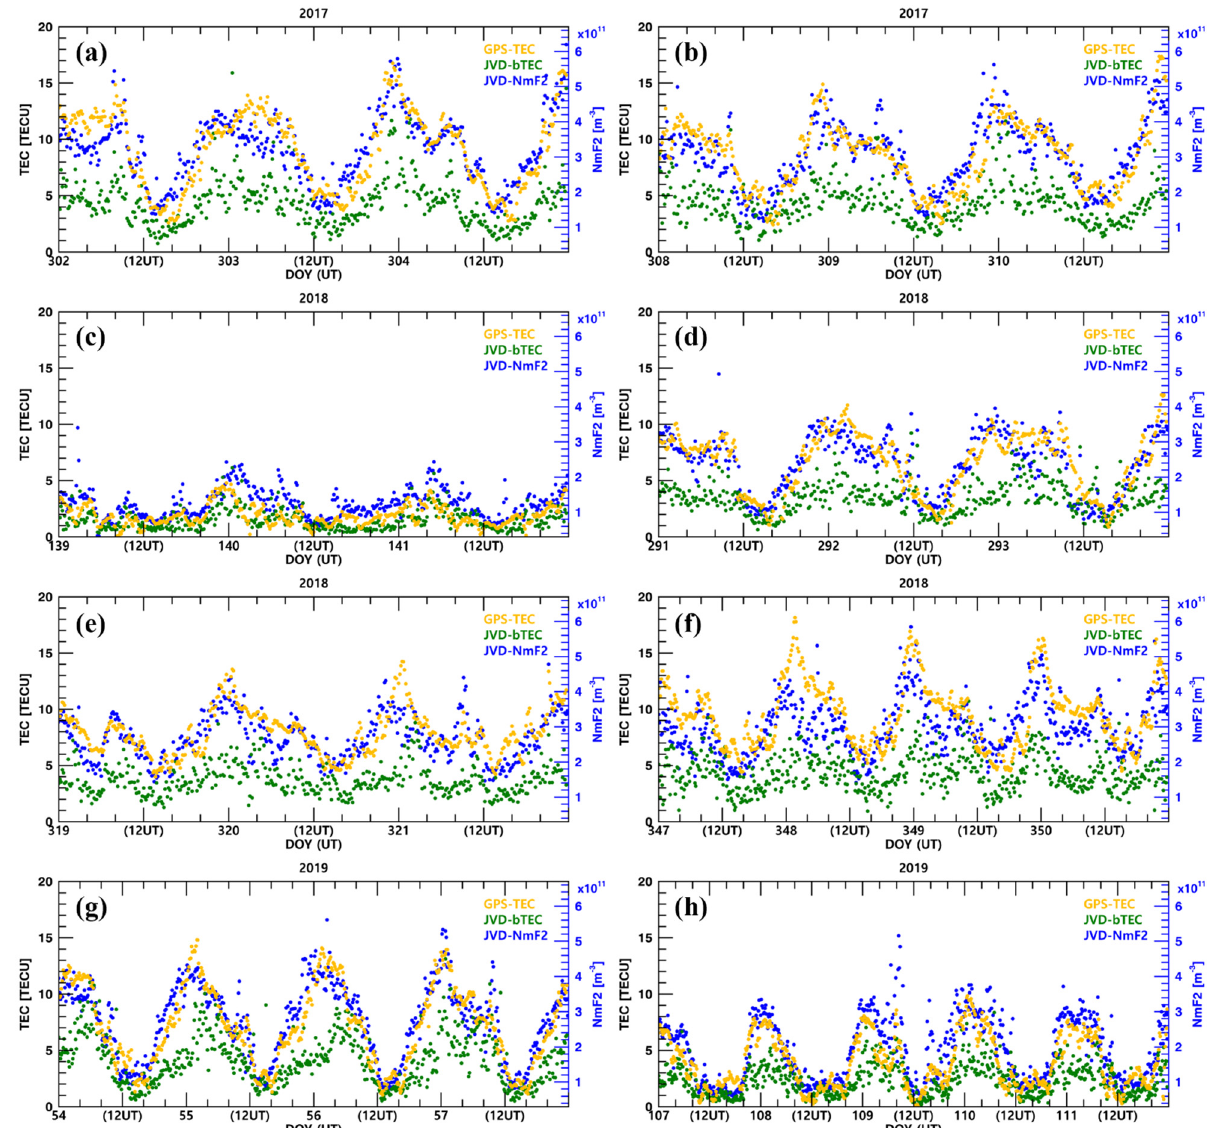
Figure 3. The diurnal variations of 10 min averaged JVD bTEC (green), NmF2 (blue), and GPS TEC (yellow) for eight IQDs. Note that LT = UT + 11 at JBS. The eight IQD cases include DOY 302 − 304, 2017 ( a ); DOY 308 − 310, 2017 ( b ); DOY 139 − 141, 2018 ( c ); DOY 291 − 293, 2018 ( d ); DOY 319 − 321, 2018 ( e ); DOY 347 − 350, 2018 ( f ); DOY 54 − 57, 2019 ( g ); DOY 107 − 111, 2019 ( h ).